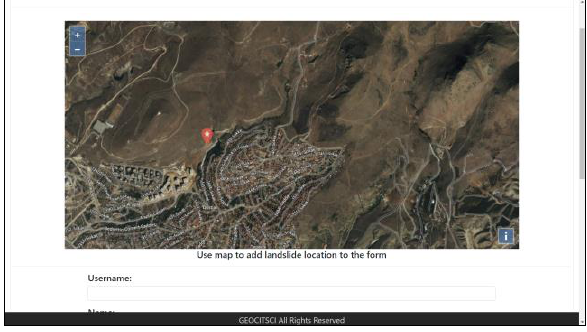
Figure 3. Location selection map on the landslide reporting page.